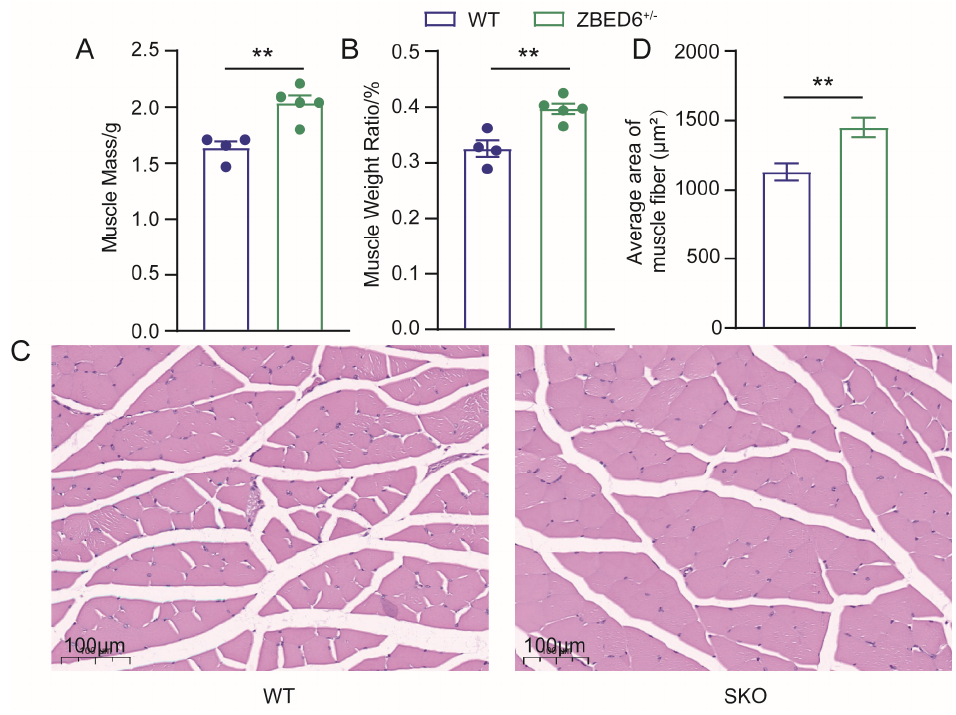
Figure 2. Phenotypes of slaughtered WT and Zbed6 +/ − mice. ( A , B ) Dissected muscle mass and muscle weight ratio of WT and Zbed6 +/ − mice. Points in different colors represent actual data of muscle traits. ( C ) H&E staining of the skeletal muscle of WT and Zbed6 +/ − mice. SKO represents Zbed6 +/ − mice. Bar, 100 μ m. ( D ) Differences in the average area of muscle fiber quantitative analysis in mice. The results were expressed by the means ± SEMs. ** p < 0.01, Student’s t-test. Points in different colors represent actual data of